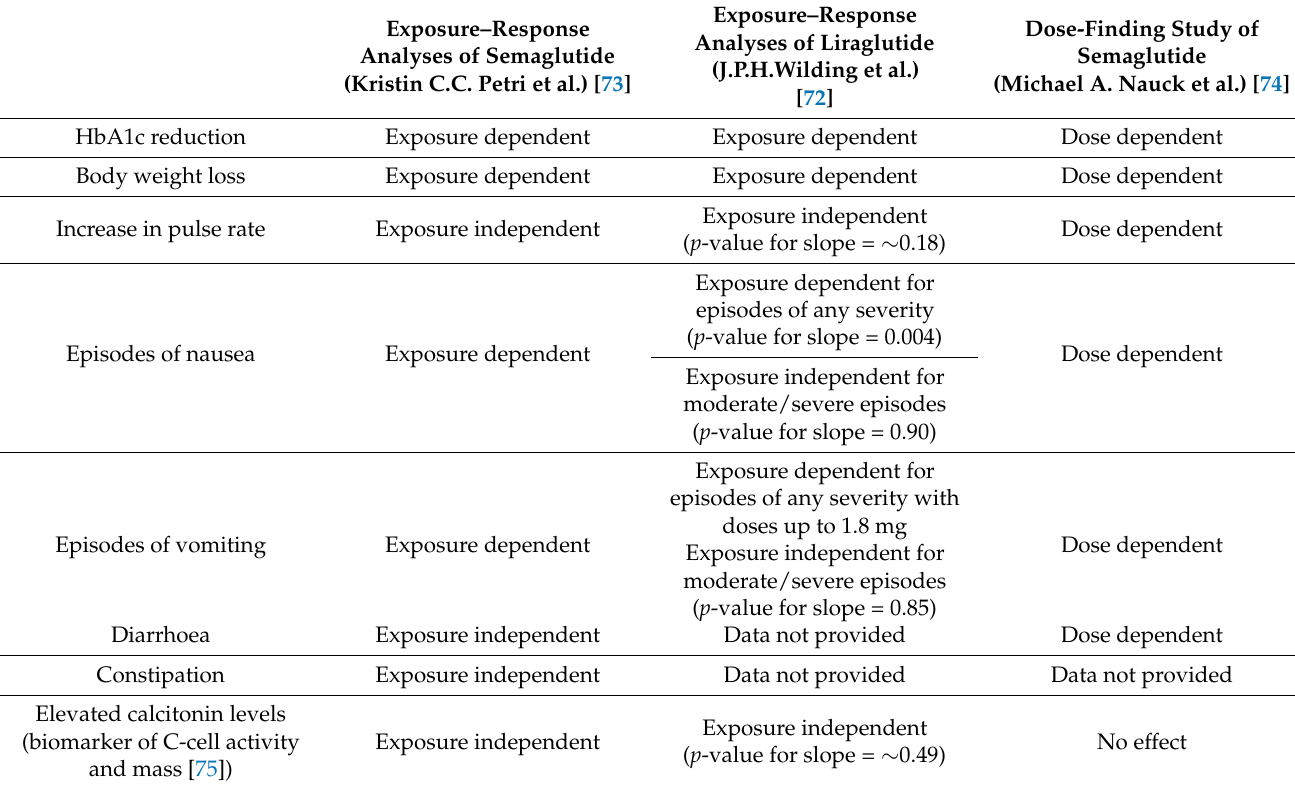
Table 2. Relationship between exposure/dose, effectiveness and AE of GLP-1